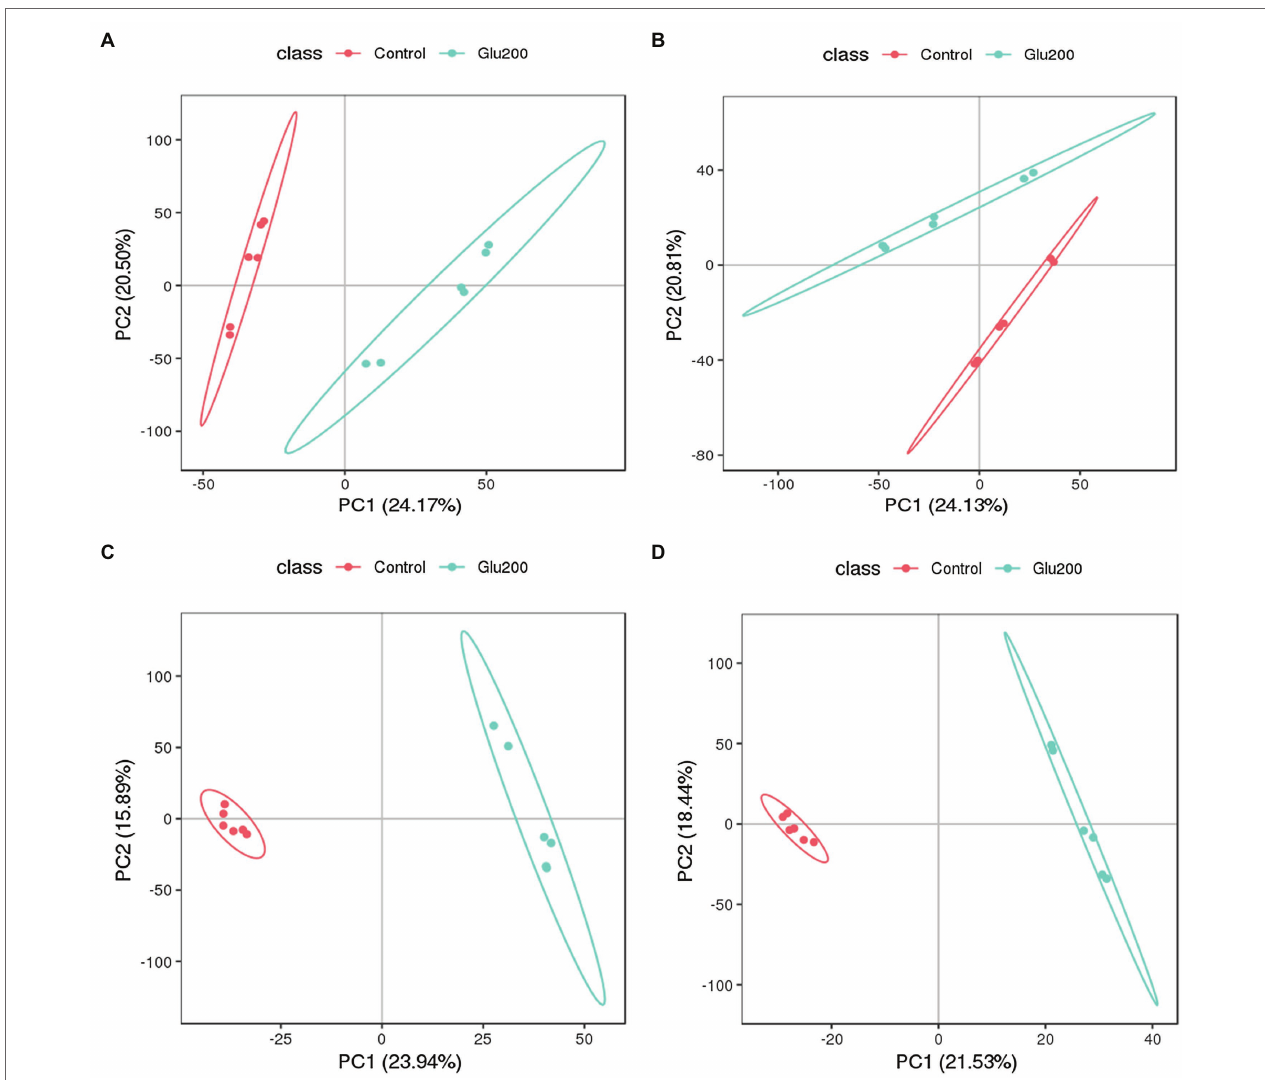
FIGURE 4 | Principal components analysis (PCA) and partial least squares discriminant analysis (PLS-DA) score plots of identified metabolites in the ileum contents of chickens ( n = 6) fed an un-supplemented control diet (Control) (red) or a basal diet supplemented with yeast β -glucan (Glu200) (blue). PCA and PLS-DA models demonstrating a separation between Control and Glu200 groups. Each dot on the plot represents the scores of the biological replicates. (A) PCA-positive ion; (B) PCA-negative ion; (C) PLS-DA-positive ion (R2 = 0.998, Q2 = 0.883); (D) PLS-DA-negative ion (R2 = 0.999, Q2 =